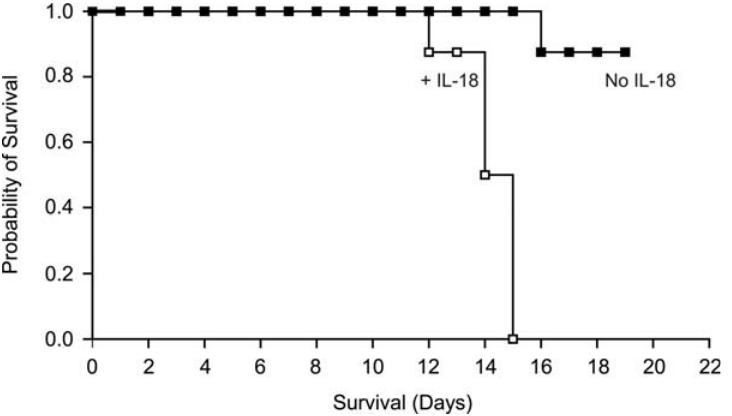
Figure 5. Human IL-18 Accelerates Xenogeneic GVHD in NOG mice. 5 6 10 6 PBMC were transferred into NOG mice on day 0, and IL-18 or PBS injected daily starting on day 1. On the x-axis are days after transfer of cells. On the y-axis is the proportion of recipients surviving (n=8/group; P , .02).